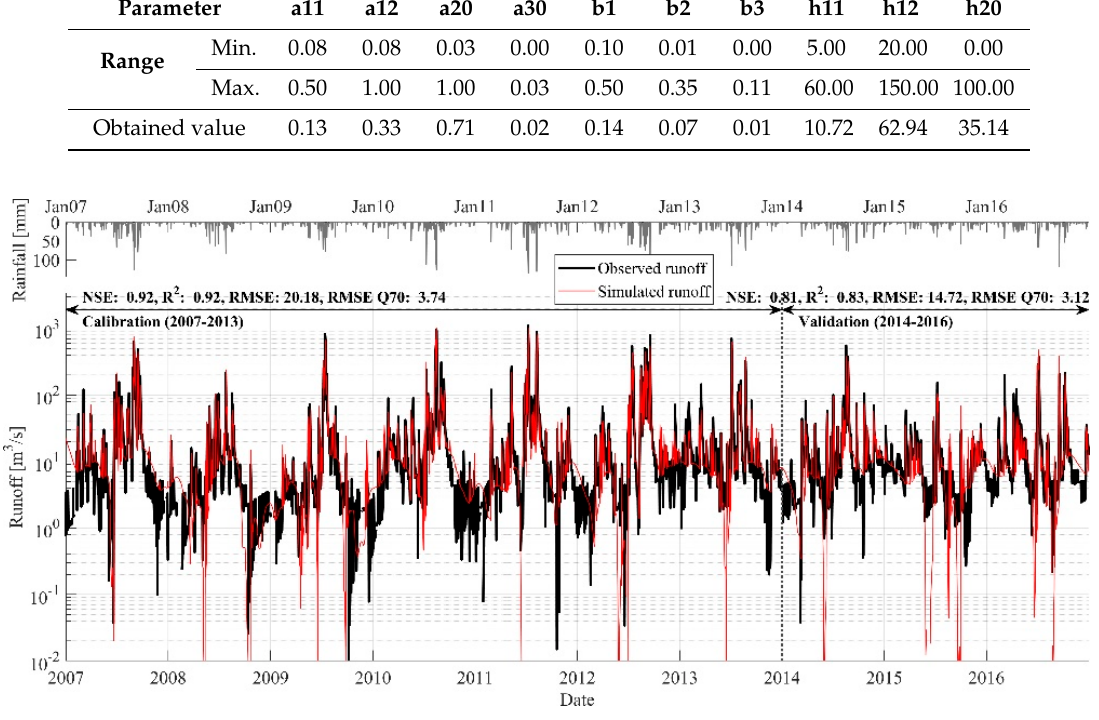
Figure 6. Time series plot showing the observed runoff and the runoff simulated by the tank model. The upper panel depicts the average catchment rainfall over the course of the investigation period.